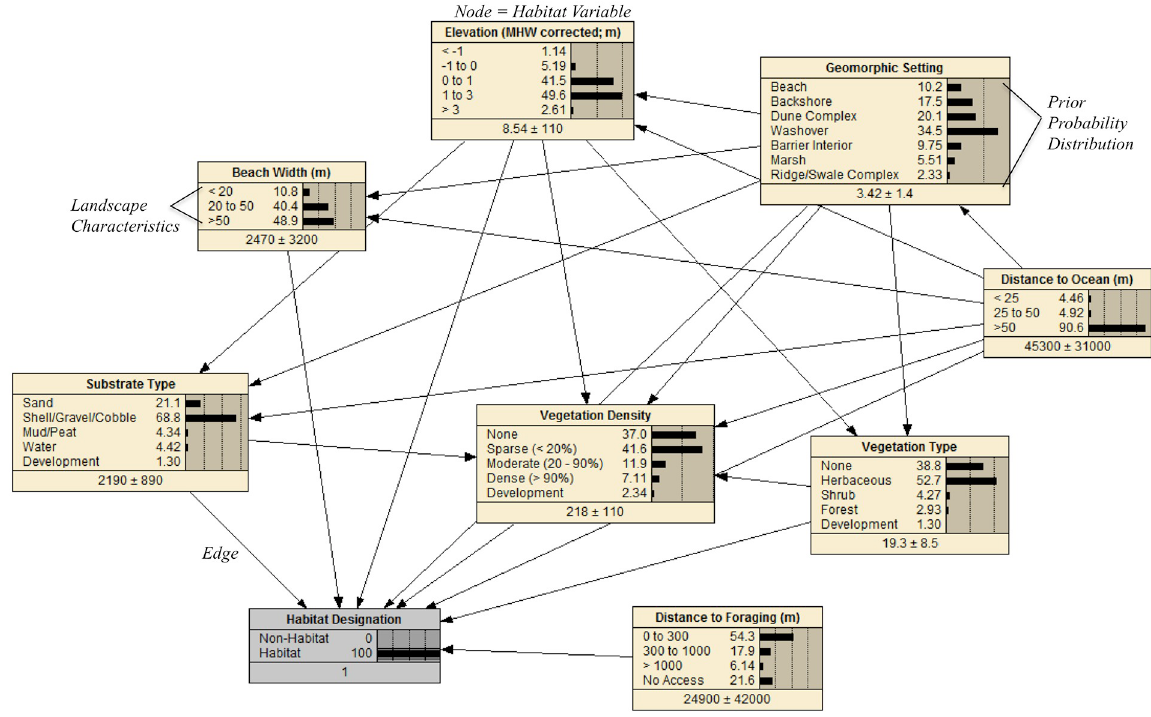
Fig 2. Configuration of nodes and edges in the Plover Habitat Bayesian network used to predictively map habitat for piping plovers. Prior probability distributions for this network were derived from data collected at piping plover nests and random points at sites in 2014 and 2015 using the iPlover data collection application. The network as shown in this figure illustrates prior probability distributions for instances where nests were present (i.e., characteristics associated with habitat).